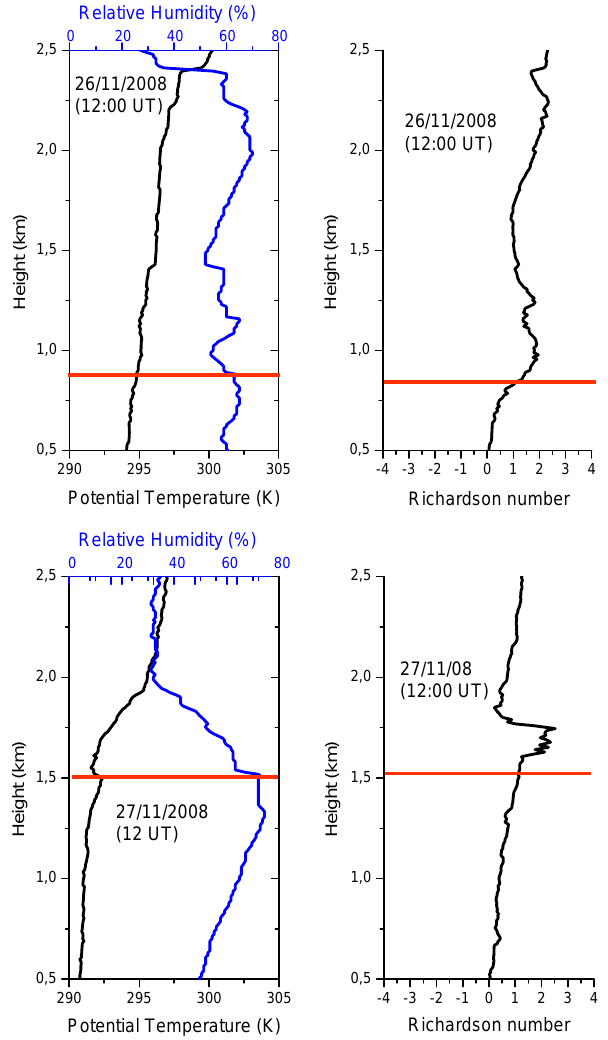
Fig. 3. Radiosonde data providing the vertical profile of the rel- ative humidity (in %), potential temperature (in K) (left side) and the Richardson number (right side), at 12:00UT over Athens, on 26 November (a) and 27 November (b) , 2008. The red lines indi- cate the PBL